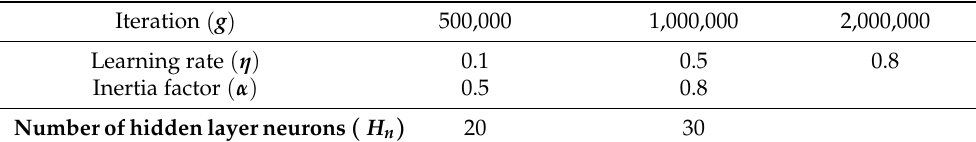
Table 11. Parameters of the back propagation neural network.